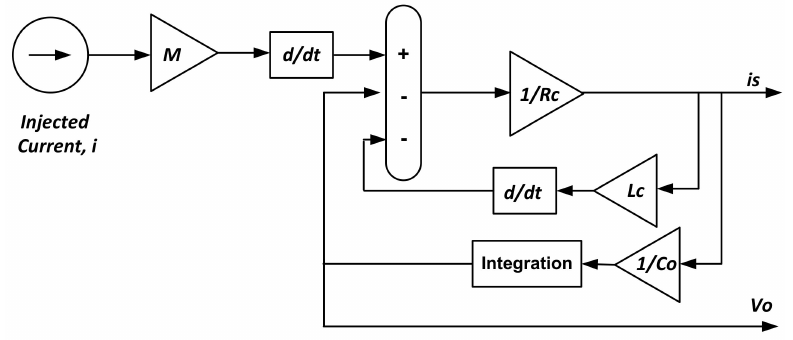
Figure 4. MATLAB SIMULINK Model of a Rogowski